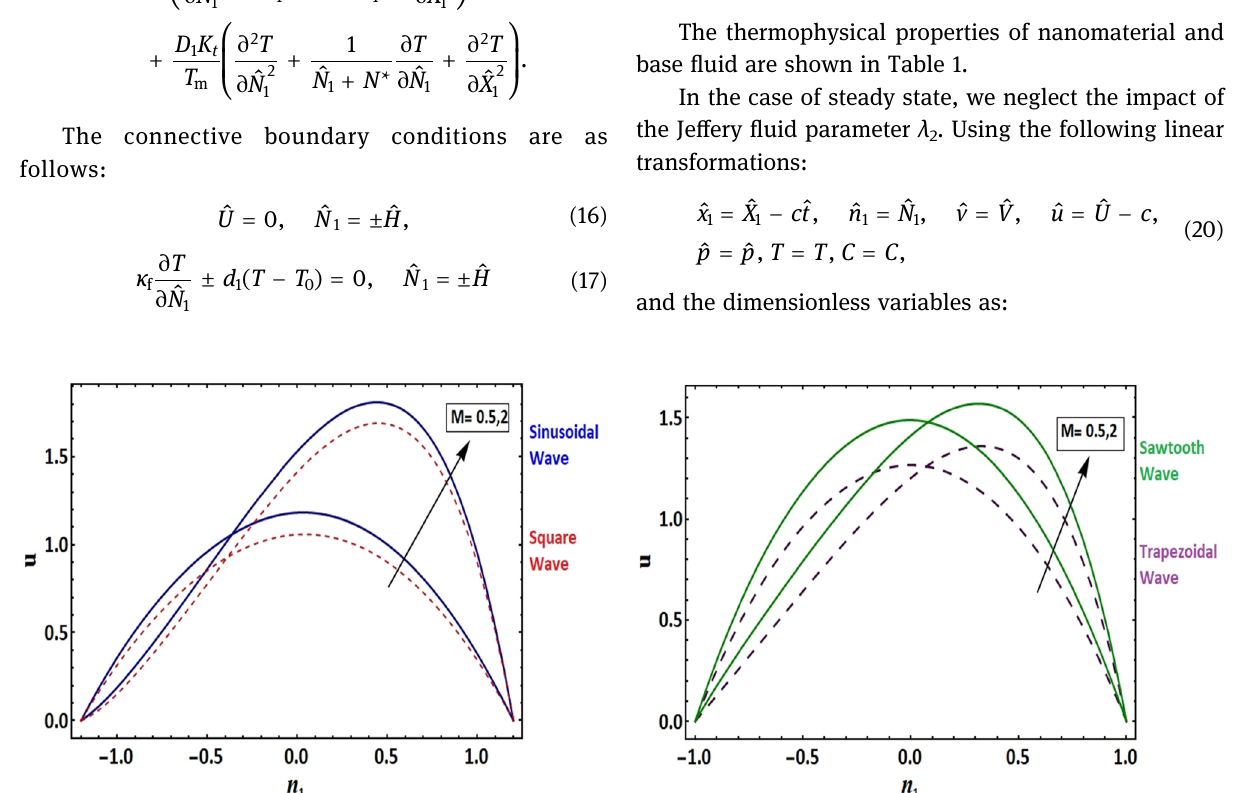
= 2, Gr = 0.4, K = 3, ϵ 0.2 = , B 0.4 3